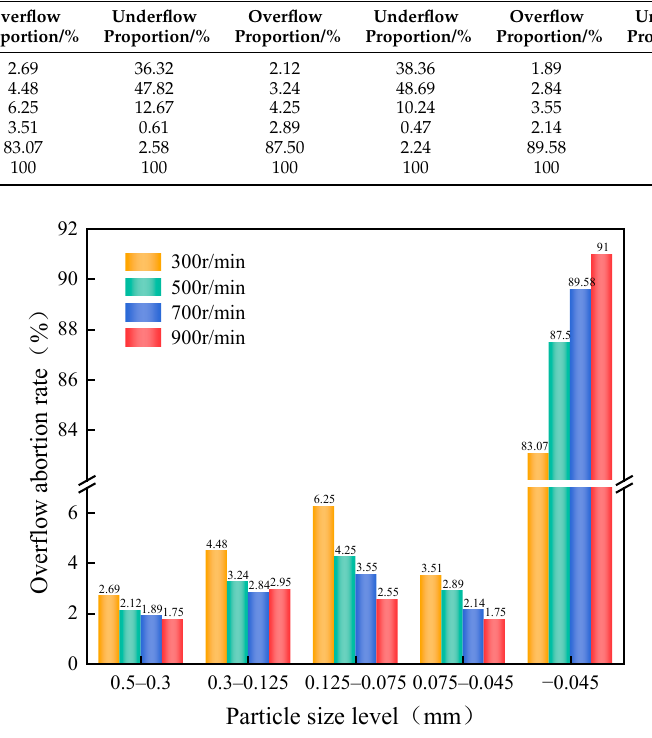
Figure 11. Variation trend of material-overflow yield